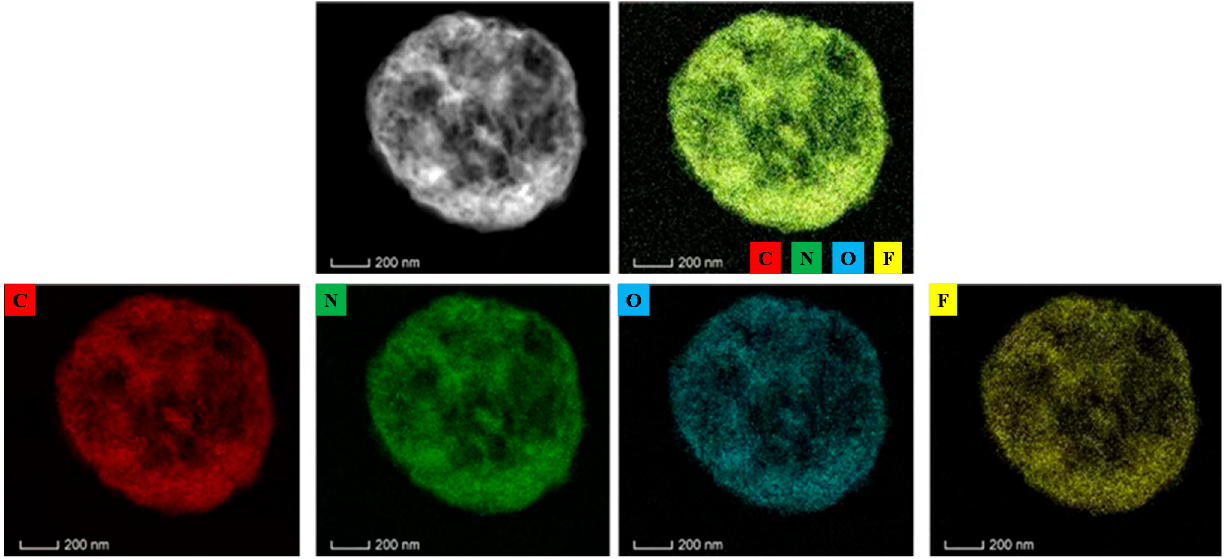
Figure 5. Energy dispersive X-ray spectroscopy mapping of RDX@PVDF particles (RDX/PVDF = 3/1).